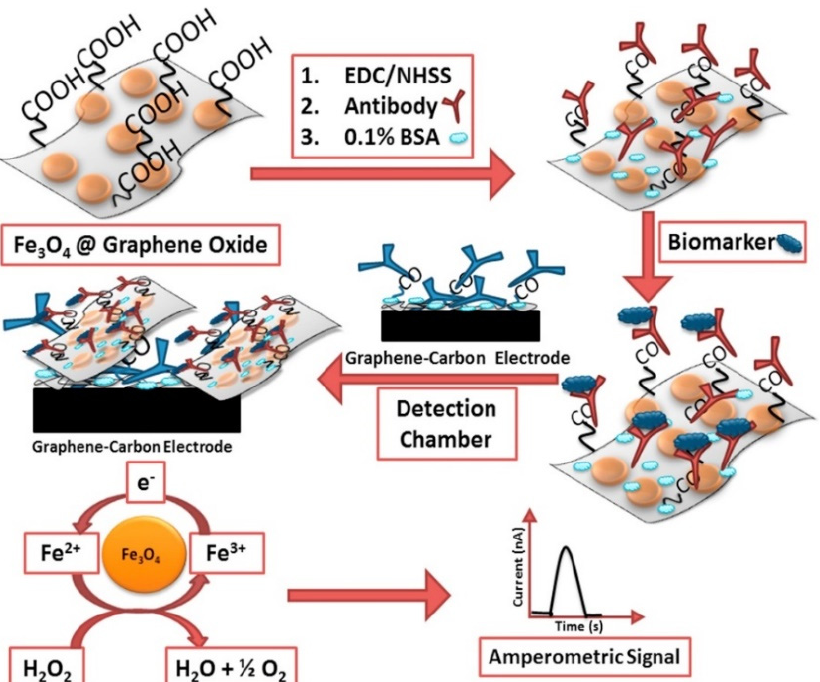
Figure 5. Schematic illustration of protein capture and detection by Fe 3 O 4 @GO sheets. After the analyte is captured by the GO sheets, it is captured on the SPCE surface coated with Ab 2 and an amperometric signal is generated using H 2 O 2 . Reprinted with permission from [90], copyright 2016 Elsevier B.V.